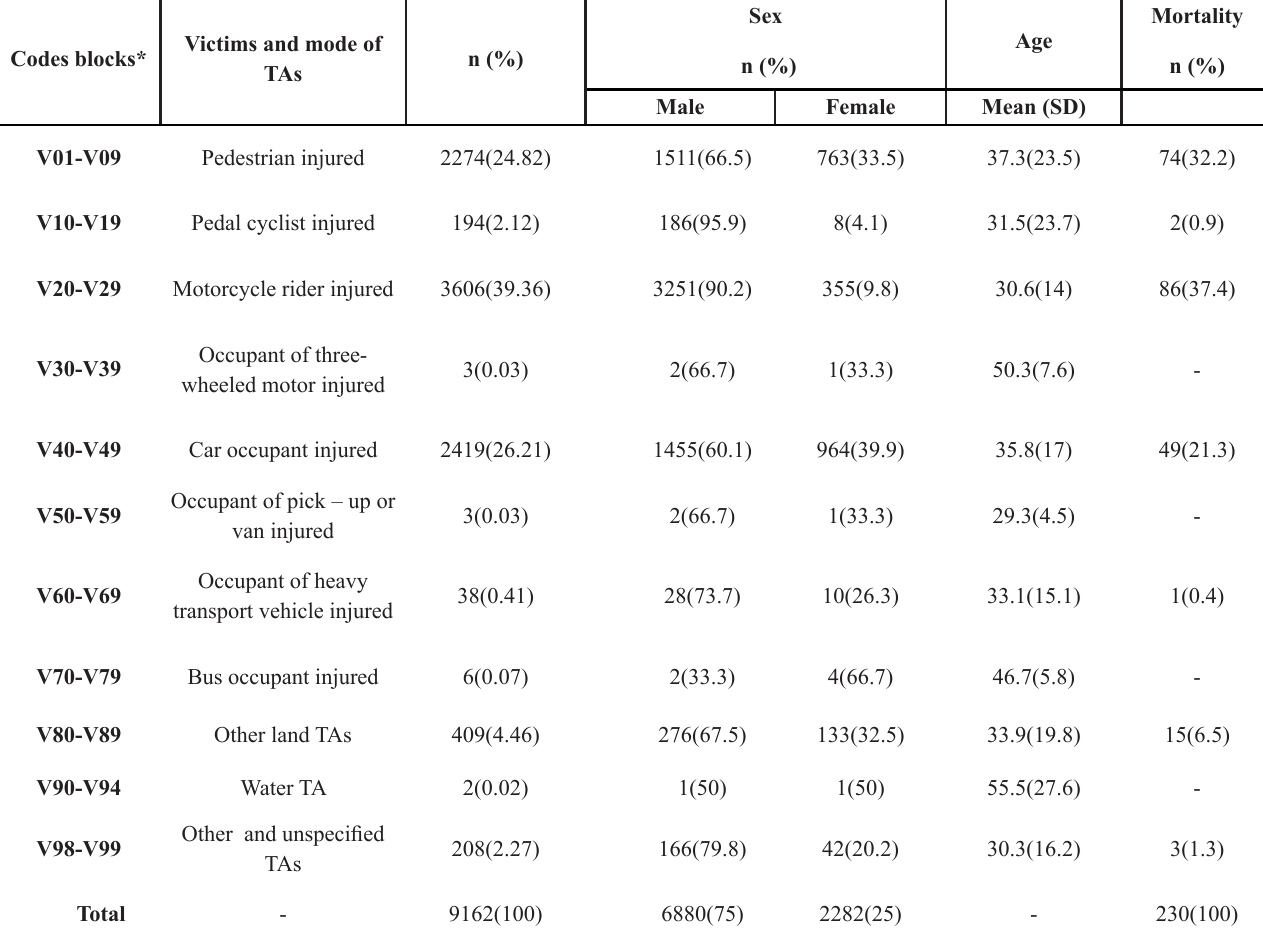
Table 1. The Number of Victims and Mode of TAs According to Codes Blocks of the ICD-10